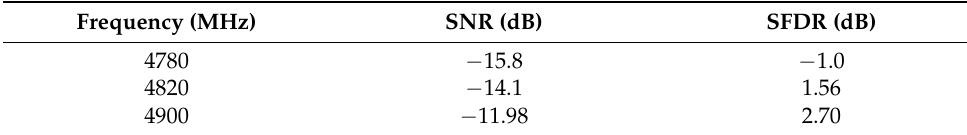
Table 2. Comparison of simulation results.